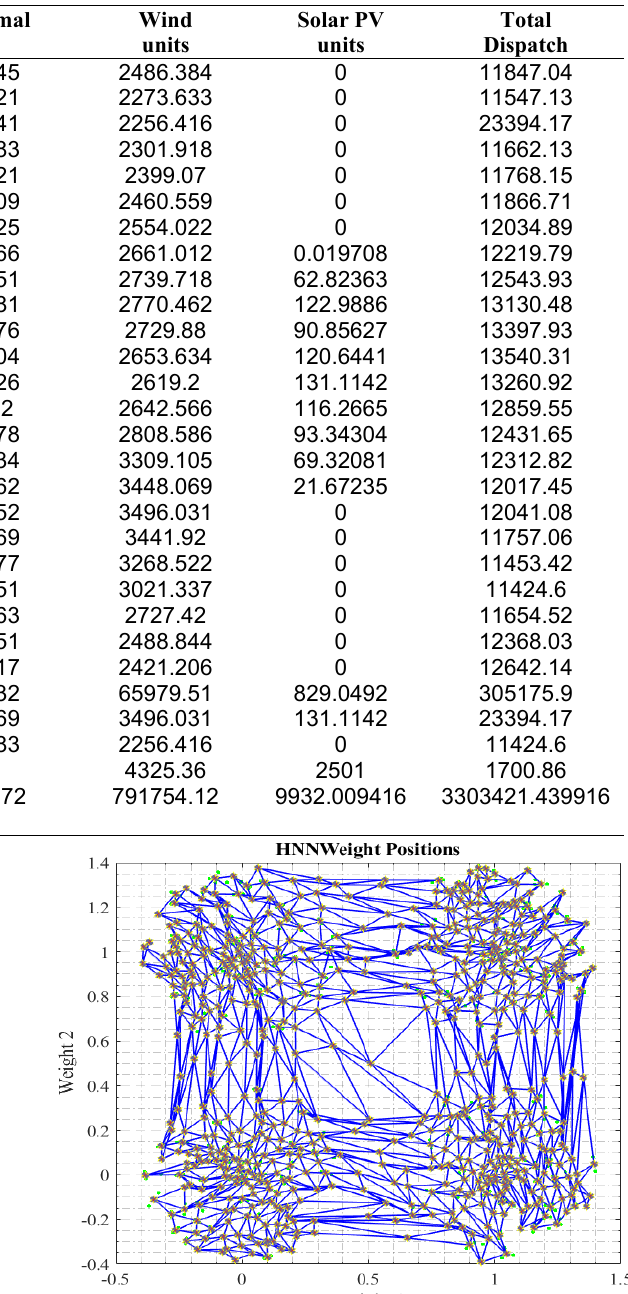
Table 2. Daily dispatch of Ethiopian renewable energy system